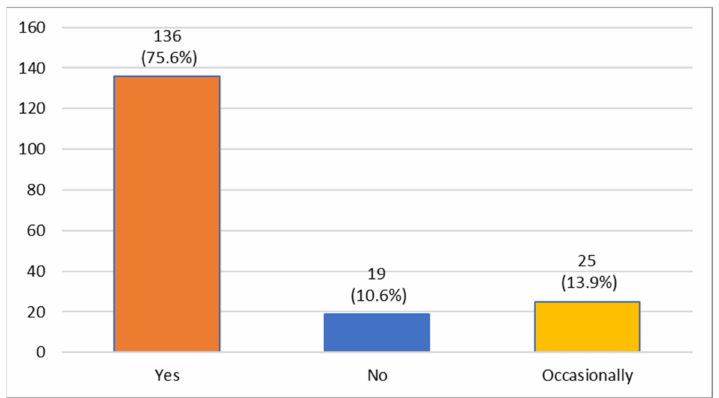
Figure 6. Distribution of the answers given by children regarding breakfast products. Additionally, a high number of children (69.5%, n = 123) have a morning snack prepared from home, while only a few take snacks from canteens (15.3%, n = 27) or food kiosks (11.9%, n = 21) (Figure